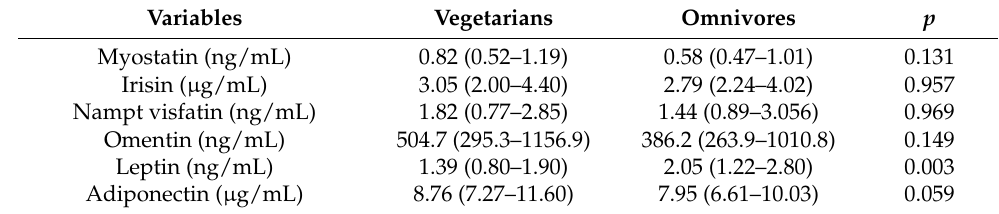
Table 3. Serum concentrations of myokines and adipokines in vegetarian and omnivorous